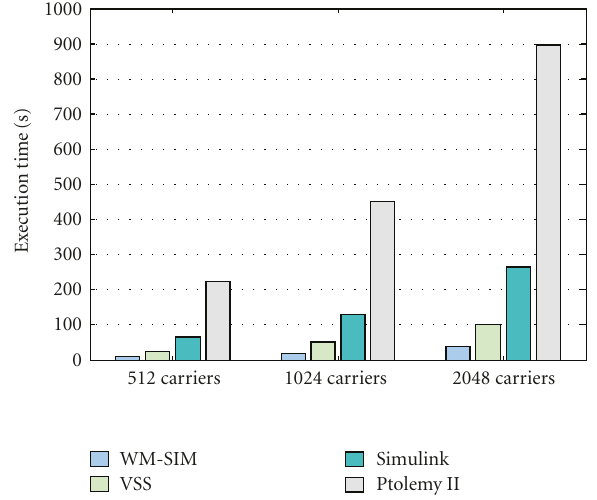
Figure 7: Execution time consumption for di ff erent simulation